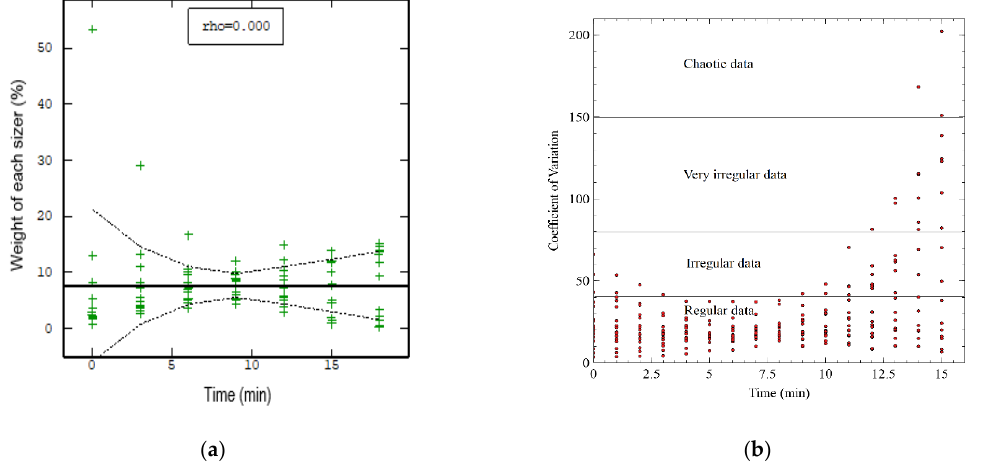
Figure 13. Results for LGP-1 for ore-A for time evolutions: ( a ) weight of each sizer fluctuation zone of the reconstructed data; ( b ) Cv for each time.